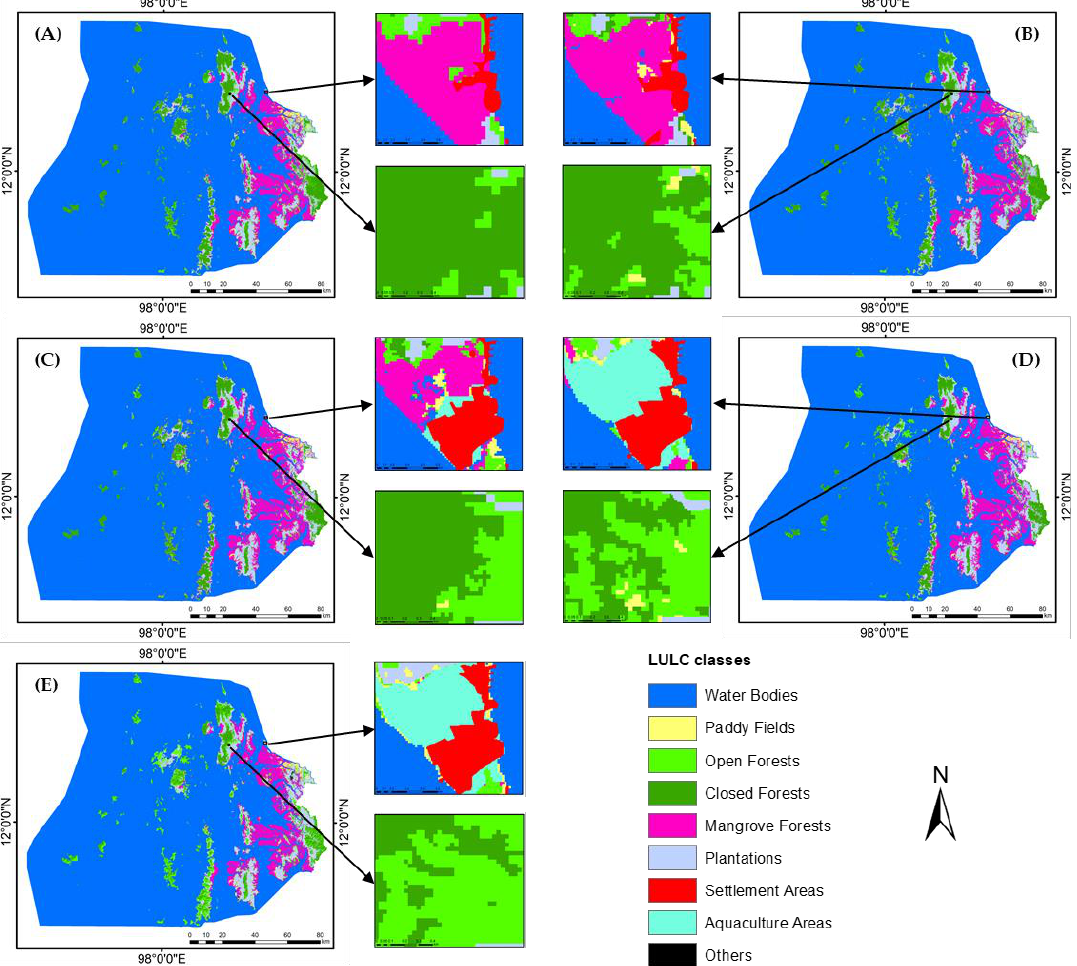
Figure 4. Final classified datasets of LULC classes in ( A ) 1978, ( B ) 1989, ( C ) 2000, ( D ) 2011, and ( E ) 2020 of Kyunsu township in Southern Myanmar. 2.6. Accuracy Assessment of the Final Classified LULC Datasets of 1978, 1989, 2000, 2011, and